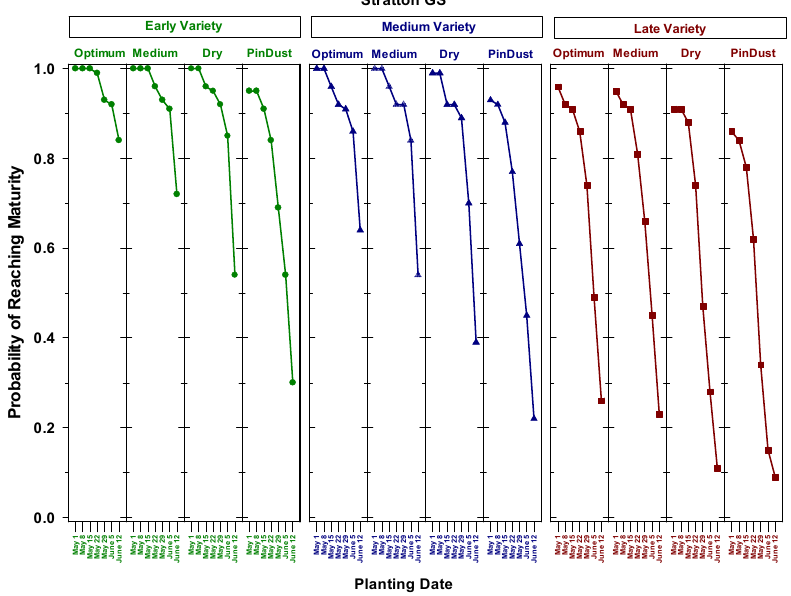
Figure 12. Probability of sorghum reaching physiological maturity at Stratton, Colorado, for seven planting dates using non-stressed (GS) phenological parameters, three maturity classes, and four seedbed water conditions at planting.